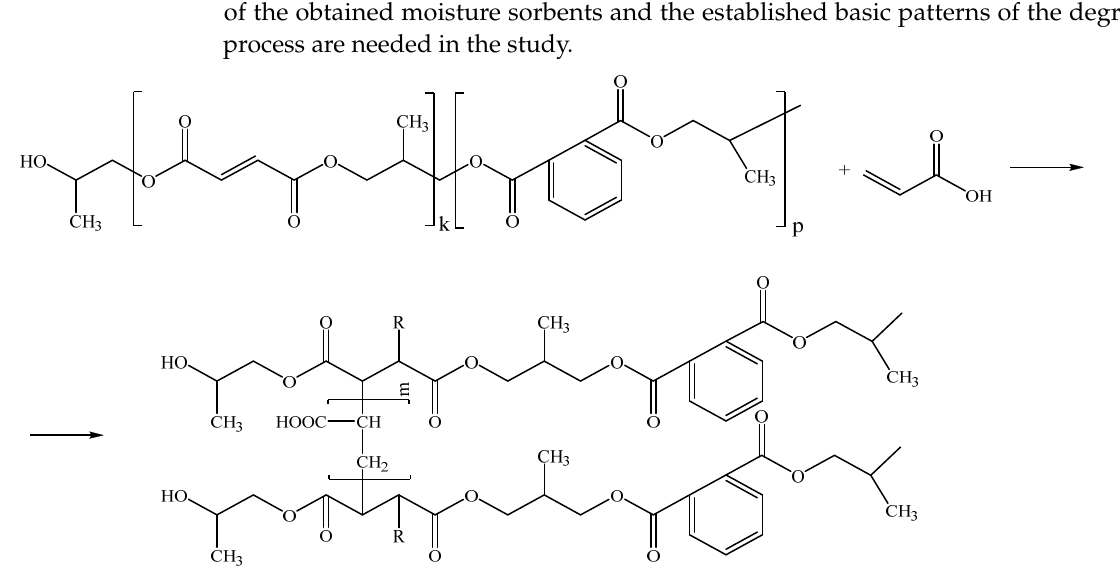
Figure 1. Brief copolymerization scheme of p-PGFPh:АА.